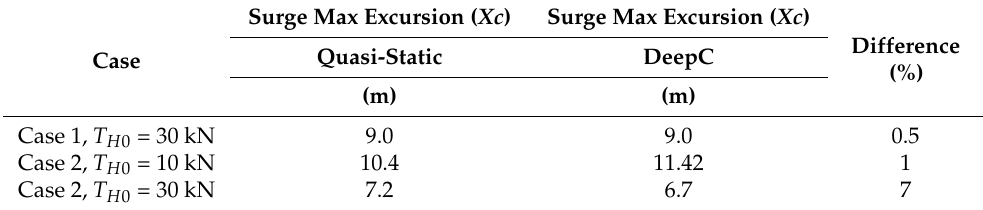
Table 21. Difference of maximum horizontal excursion between quasi-static and